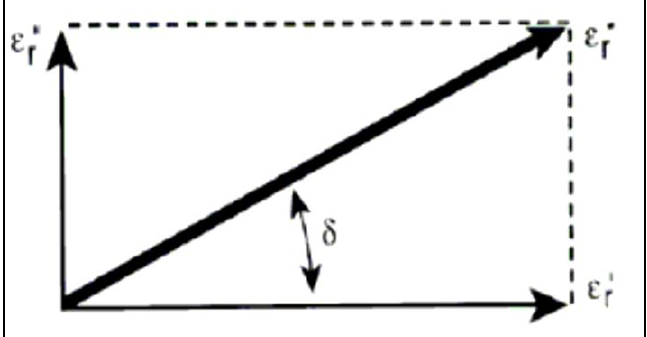
Figura 14: Diagrama Vectorial de la Permitividad compleja. Fuente: Autores, (2017).